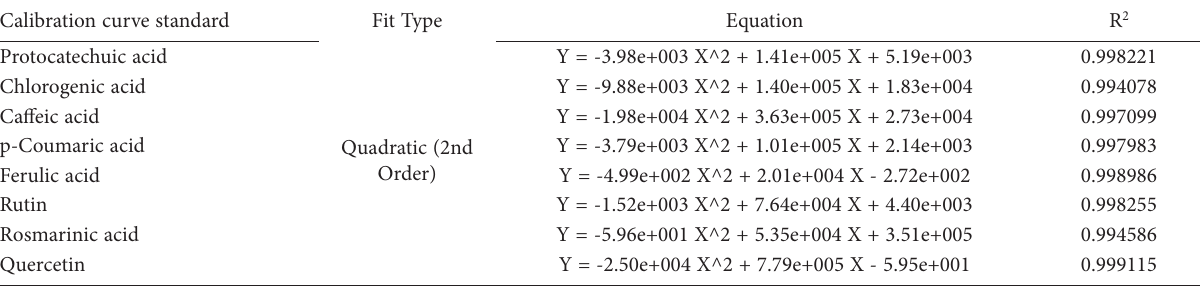
Table 2. Calibration curve statistics of reference compounds. Calibration curve standard